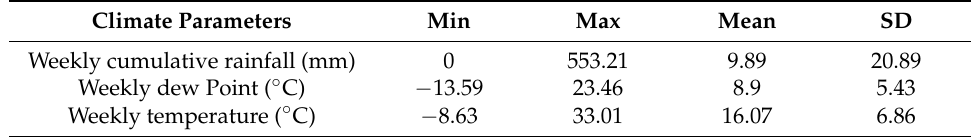
Table 2. Descriptive statistics for climate variables in Spain 2010/11 to 2014/15.